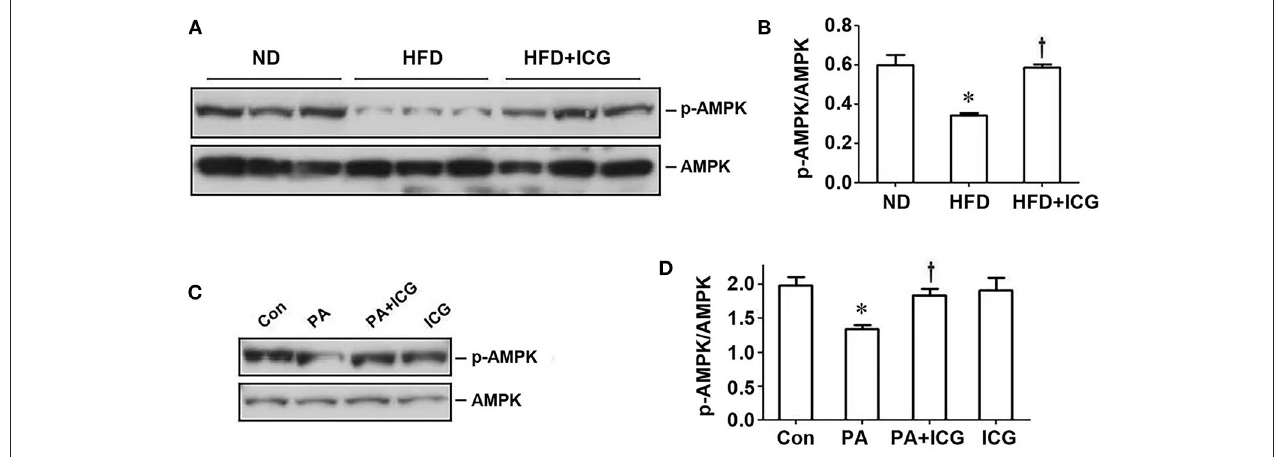
FIGURE 6 | ICG-001 restores AMPK phosphorylation repressed by HFD in vivo or palmitate in vitro. (A,B) Western blot analyses show that ICG-001 restored renal AMPK phosphorylation in mice fed with high-fat diet for 13 weeks. Representative western blot (A) and quantitative data (B) are presented. (C,D) ICG-001 restored p-AMPK expression after palmitate treatment. Representative western blot (C) and quantitative data (D) are presented. Con, control; PA, palmitate; ICG, ICG-001. * P < 0.05, Con vs. PA, † P < 0.05PA vs. PA + ICG, n =